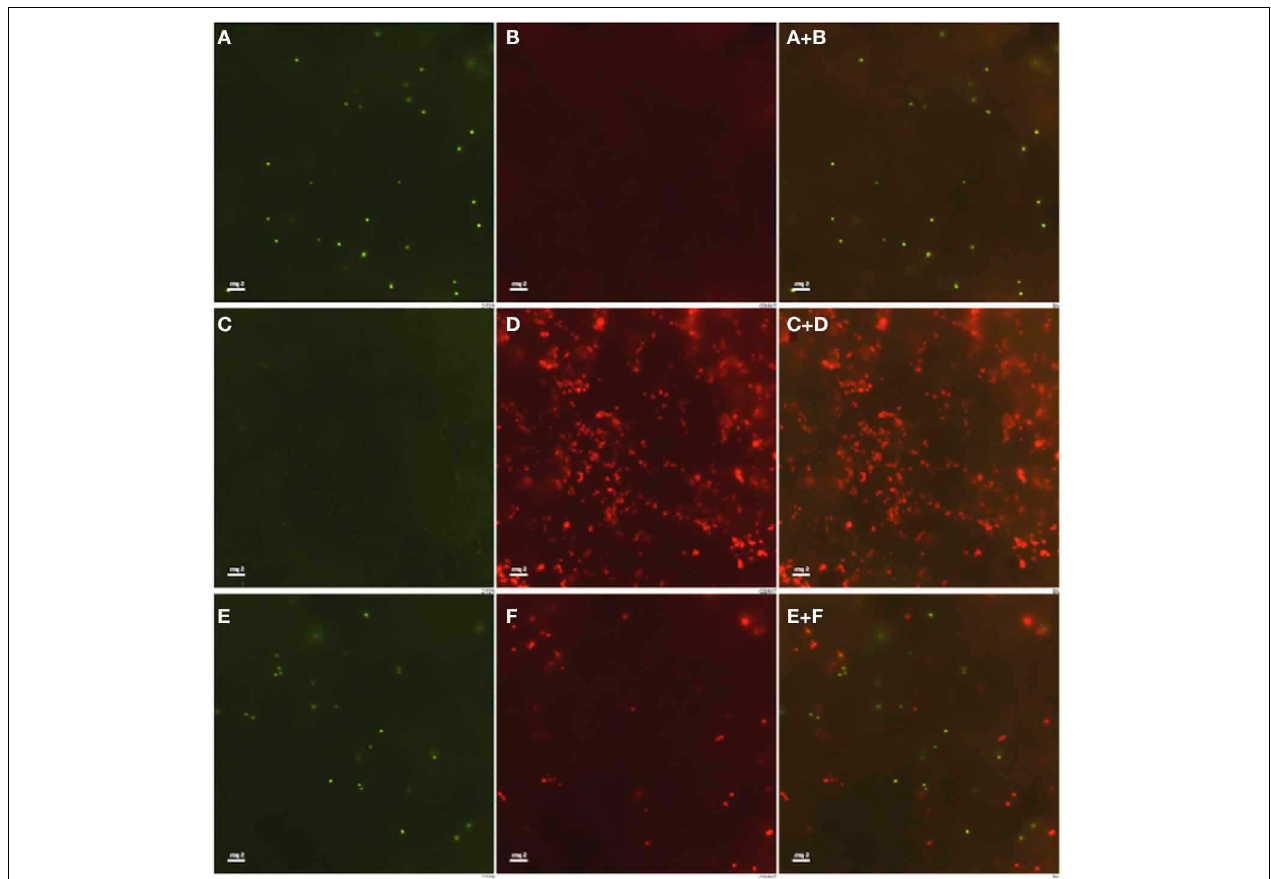
FIGURE 5 | Double antibody staining differentiates rough variants from smooth Brucella . J774.A1 macrophages were inoculated at an MOI of 50 with 16M (A,B) , 16M (cid:2) manBA (C,D) or a 10:1 mixture of 16M and 16M (cid:2) manBA (E,F) . The cells were fixed at 1h p.i. and incubated with rabbit mono-specific anti-M serum (1:500 in PBS-TT) and goat anti- B. ovis serum